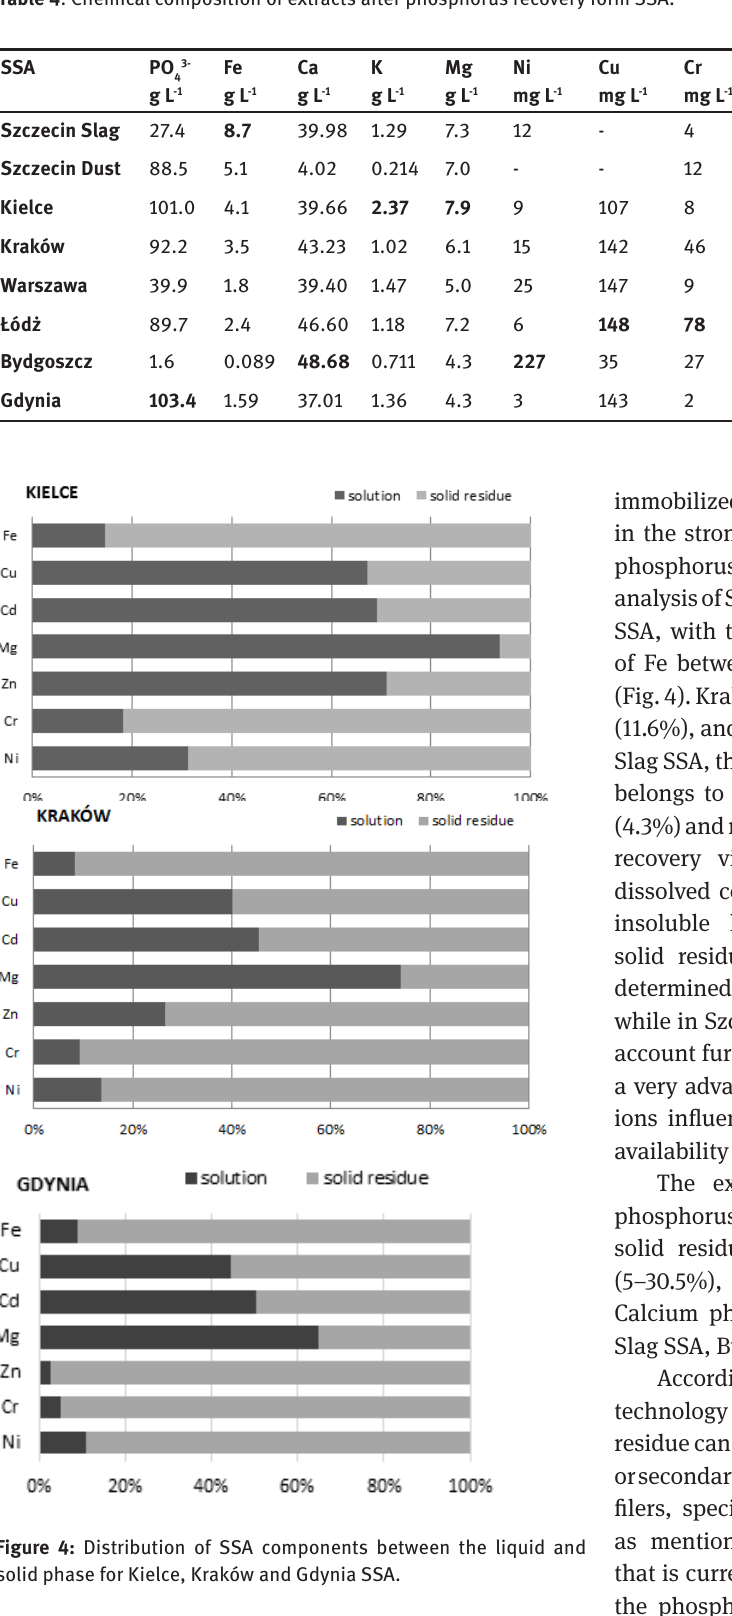
Table 4 : Chemical composition of extracts after phosphorus recovery form SSA.